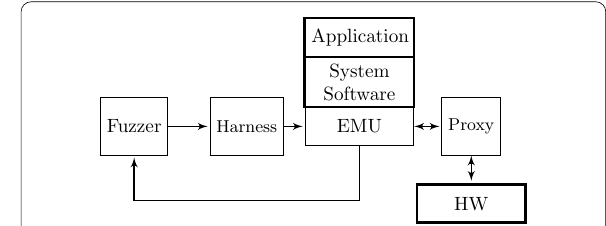
Fig. 4 Scheme of fuzzing embedded applications in a full-system emulator